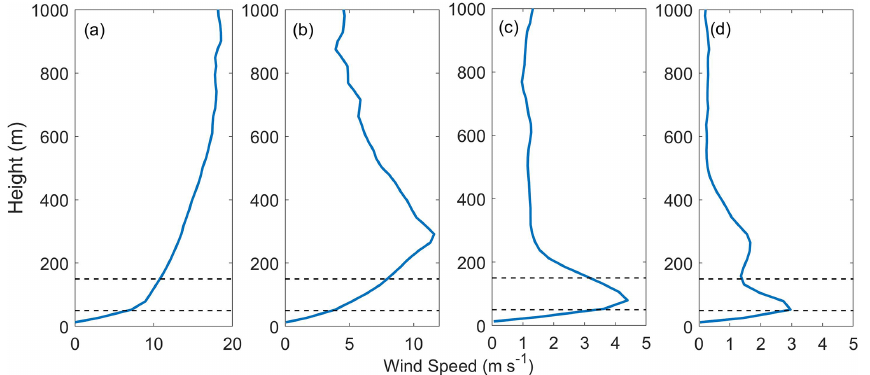
Figure 16. Examples of wind profiles with different vertical shears in the horizontal wind speed: (a) strong shear without the presence of a NLLJ, (b) strong shear due to a NLLJ, (c) a NLLJ with the core inside the rotor layer and (d) a NLLJ immediately below the rotor layer. The dashed lines mark the mean rotor layer of 50–150ma.g.l.